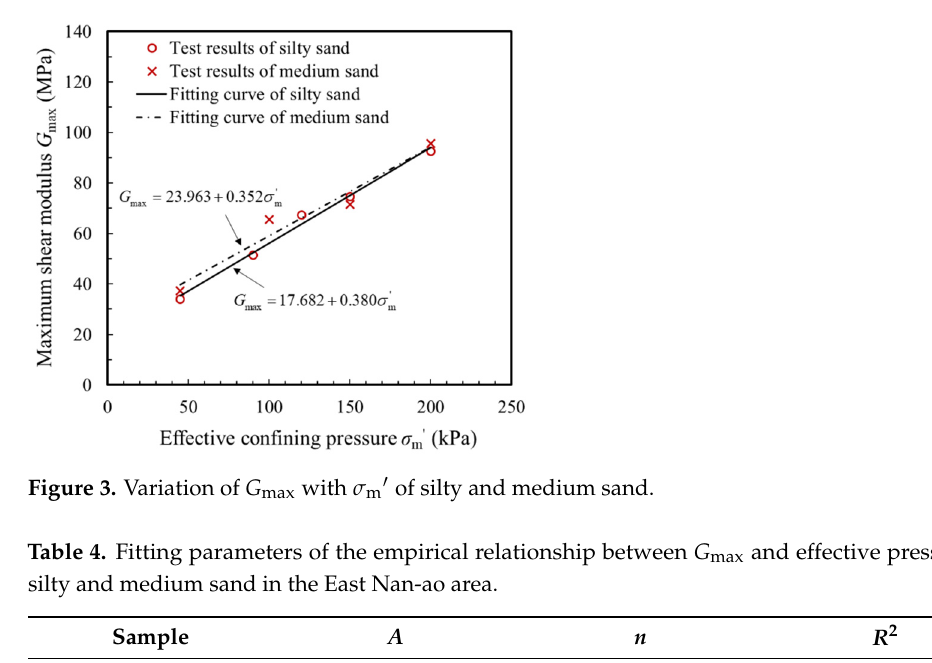
( b ) Figure 2. The apparatus used in this test: ( a ) GDS resonant column device; ( b ) GDS cycle triaxial device. 3. Results of Resonant Column Test and Prediction Model of Shear Modulus 3.1. Maximum Shear Modulus